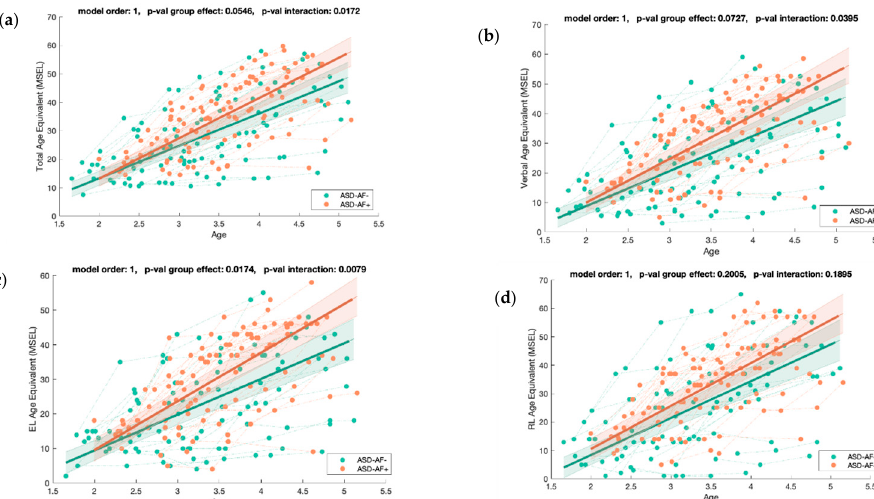
Figure A7. Mixed model regression analysis for the MSEL Total Age Equivalent ( a ), Verbal Age Equivalent ( b ), Expressive Language Age Equivalent ( c ), and Receptive Language Age Equivalent ( d ) for 211 longitudinal recordings from 71 young children with ASD (2.82 ± 0.60 years old) with lower ( ASD-AF- ) or higher ( ASD-AF+ ) social orienting at baseline. The group-level trajectory (bold line) is derived from mixed-effect modeling [43–45]. The 95% confidence interval is indicated by the colored bands around the estimated group-level trajectory.